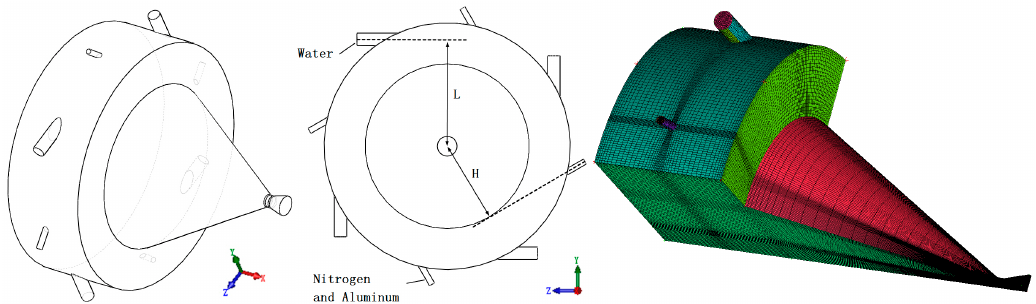
Figure 1. Vortex combustor configuration